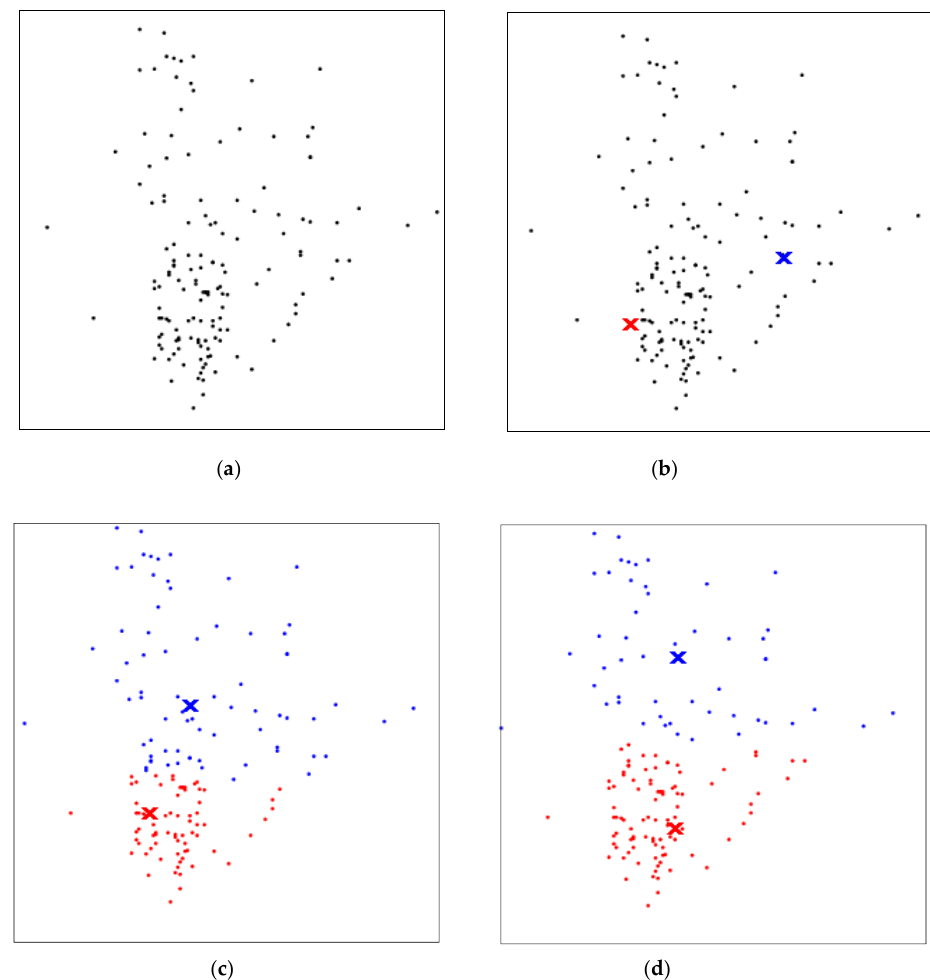
Figure 1. The process of K-means. ( a ) An original dataset; ( b ) randomly selecting two points as cluster centroids; ( c ) updating cluster centroid; ( d ) determining the final cluster centroids and two sub-clusters after iterations.